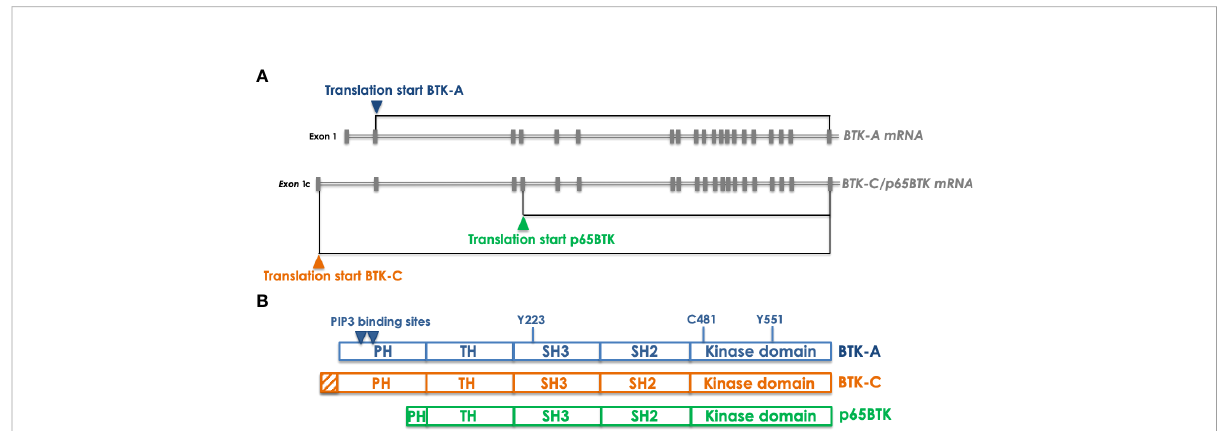
FIGURE 2 Transcripts encoding the different BTK isoforms and the corresponding proteins. (A) organization of the BTK-A- and BTK-C/p65BTK-encoding transcripts. The only variation between the two mRNAs is a different exon 1 which is uncoding in BTK-A transcript and encoding in the BTK-C one. In addition, the same mRNA can be translated also from an ATG located in the 4th exon thus giving raise to p65BTK. Gray boxes indicate exons. Translation starts are indicated by colored triangles. (B) Domain organization of the BTK isoforms. Compared to BTK-A BTK-C has an extended PH domain whereas p65BTK miss most of it. Indicated by triangles are the PIP3 binding sites that allow dimerization and membrane translocation. Y551and Y223 are the sites of phosphorylation that regulate BTK activation. C481 is the critical residue (gatekeeper) in the kinase domain targeted by most BTKis.